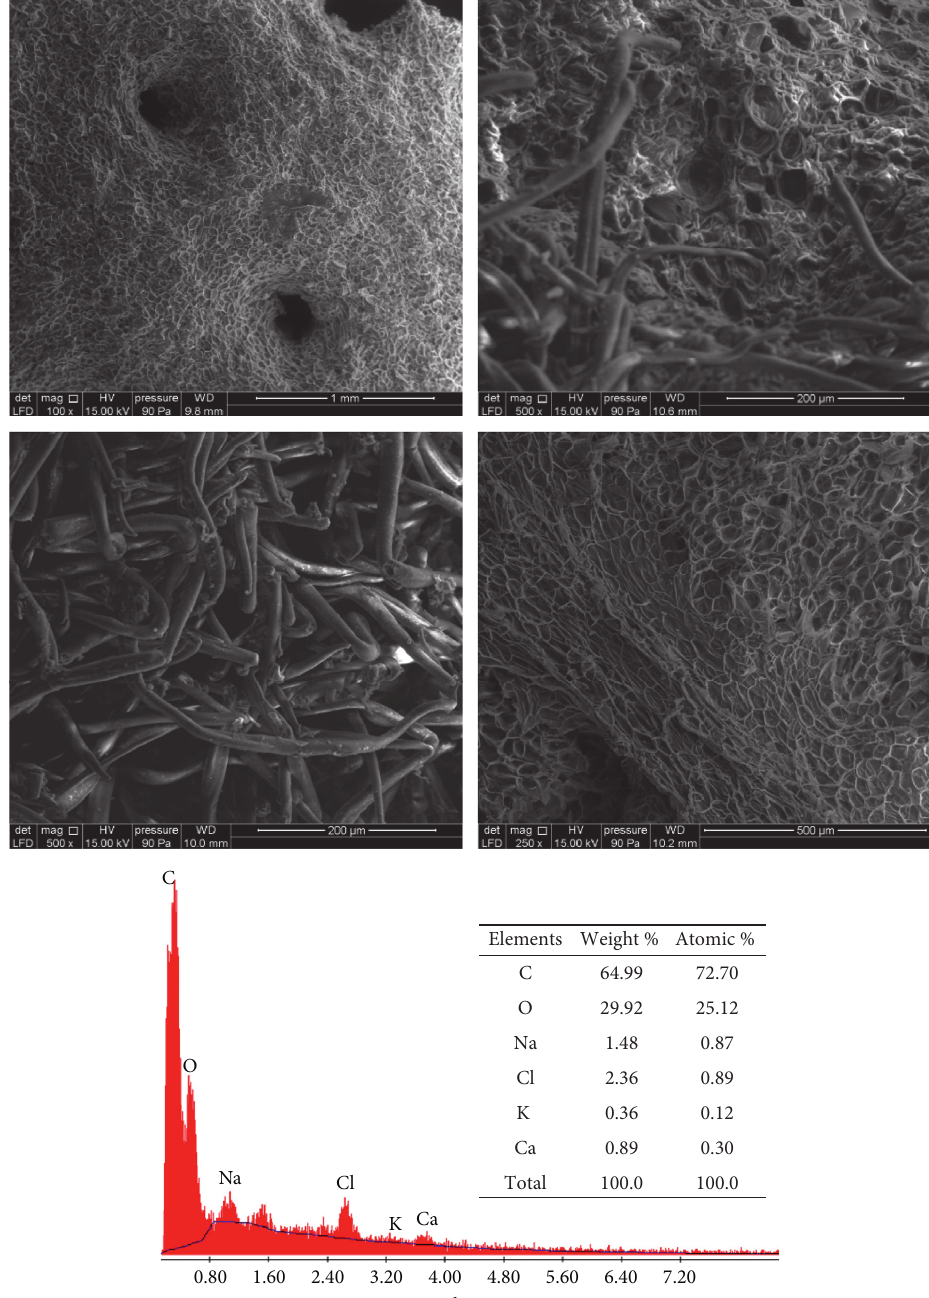
Figure 3: SEM micrographs coupled by EDX of almond shell powder (ASP) at different magnifications, showing surface morphology and porous